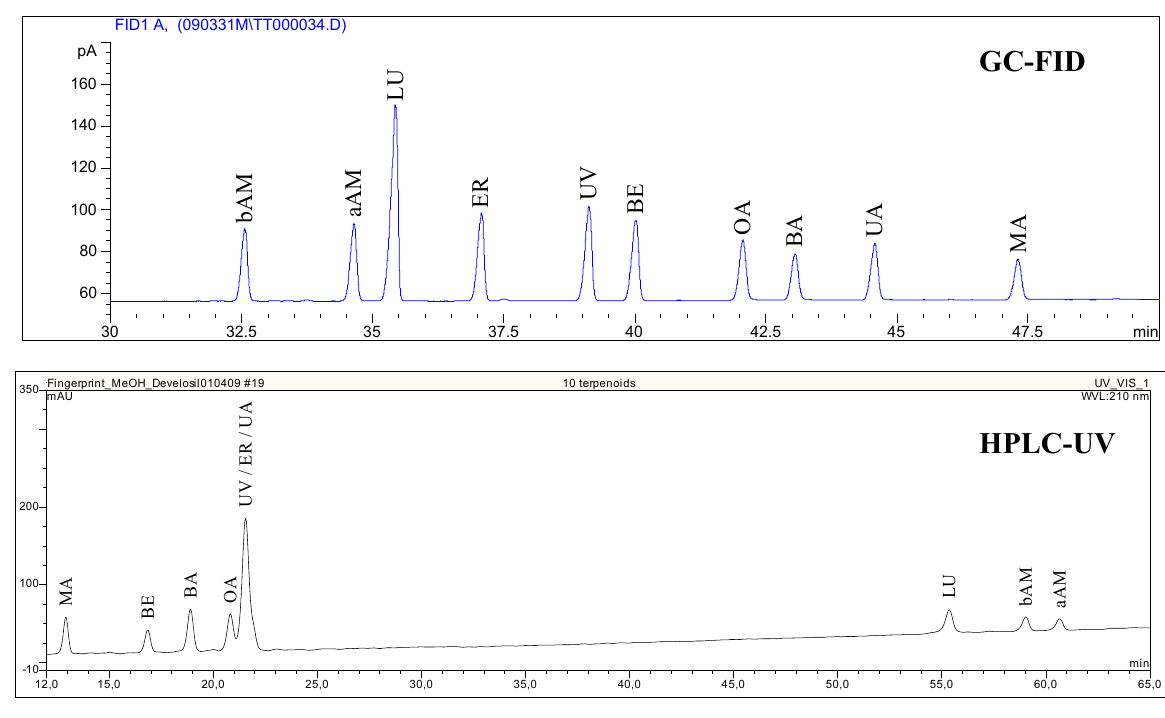
Figure 5. GC-FID and HPLC-UV chromatogram of triterpene